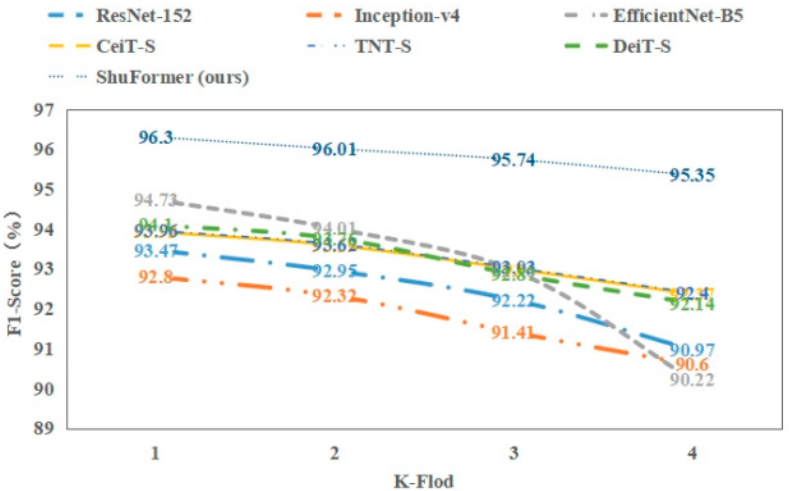
Figure 11. Comparison between ShuFormer, Inception-v4, EfficientNet-B5, CeiT-S, TNT-S, DeiT-S, and ResNet-152 on their respective performance with different number of 𝐾 .